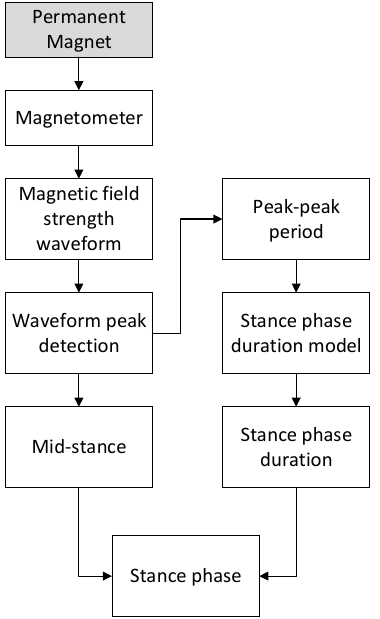
Figure 14. Flowchart of mag-ZUPT. Mid-stance (peak) is extracted from magnetic field strength waveforms. Peak-peak period is used to distinguish walking/running gait patterns and then to obtain stance phase duration. Finally, mid-stance is expanded to stance phase.